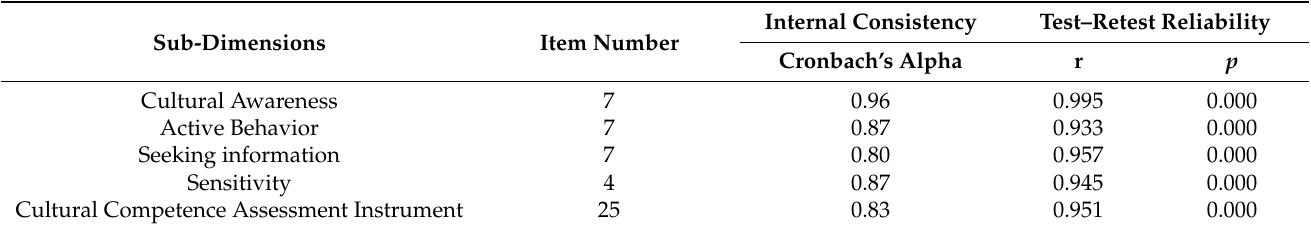
Table 2. Internal consistency and test–retest reliability for the